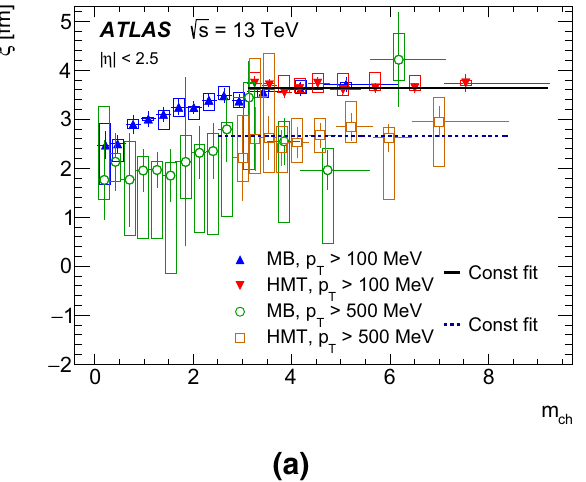
Fig. 11 The parameters a ξ and b κ (Eq. (9)), describing the depen- dence of the source radius, R , on charged-particle scaled multiplic- ity, m ch , for track p T > 100 MeV and track p T > 500 MeV in the minimum-bias (MB) and high-multiplicity track (HMT) samples √ s = 13 TeV. The error bars and boxes represent the statisti- at cal and systematic contributions, respectively. a The black solid and